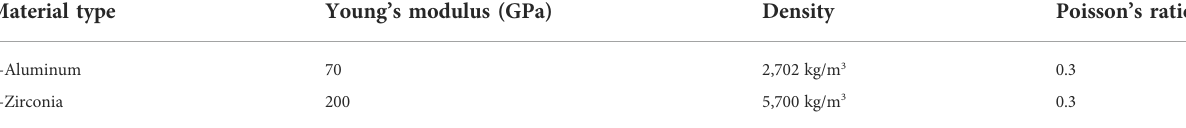
TABLE 1 Material Properties of FG